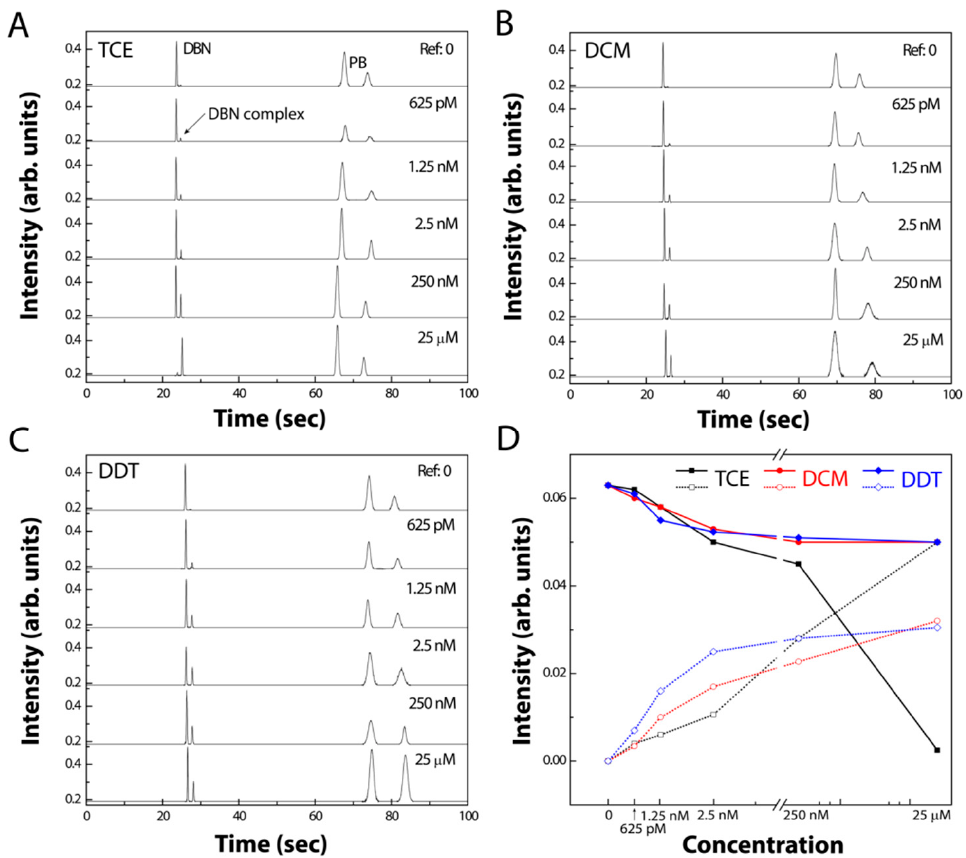
Figure 5. Electropherograms of the mixture of DBN and various concentrations (0~25 μ M) of ( A ) TCE, ( B ) DCM, and ( C ) DDT. ( D ) A plot obtained from the peak area of DBN and organochloride-DBN complex with various concentrations. Solid lines with closed circles for DBN; dotted lines with open circles for organochloride-DBN complex.